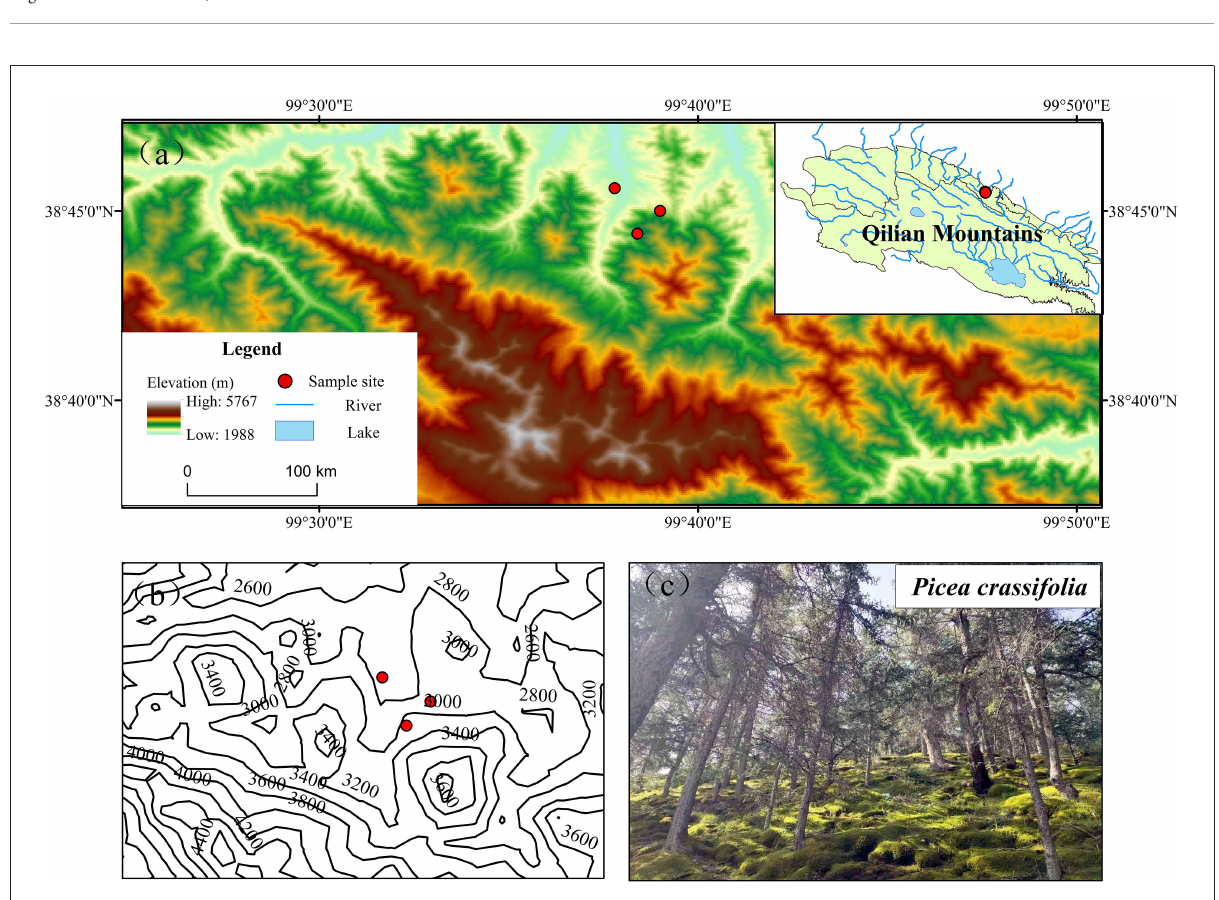
FIGURE1 Locations of the three sampling sites forming the elevation gradient. Elevation maps of sampling sites (a) ; contour maps (b) ; photos of Qinghai spruce (c)